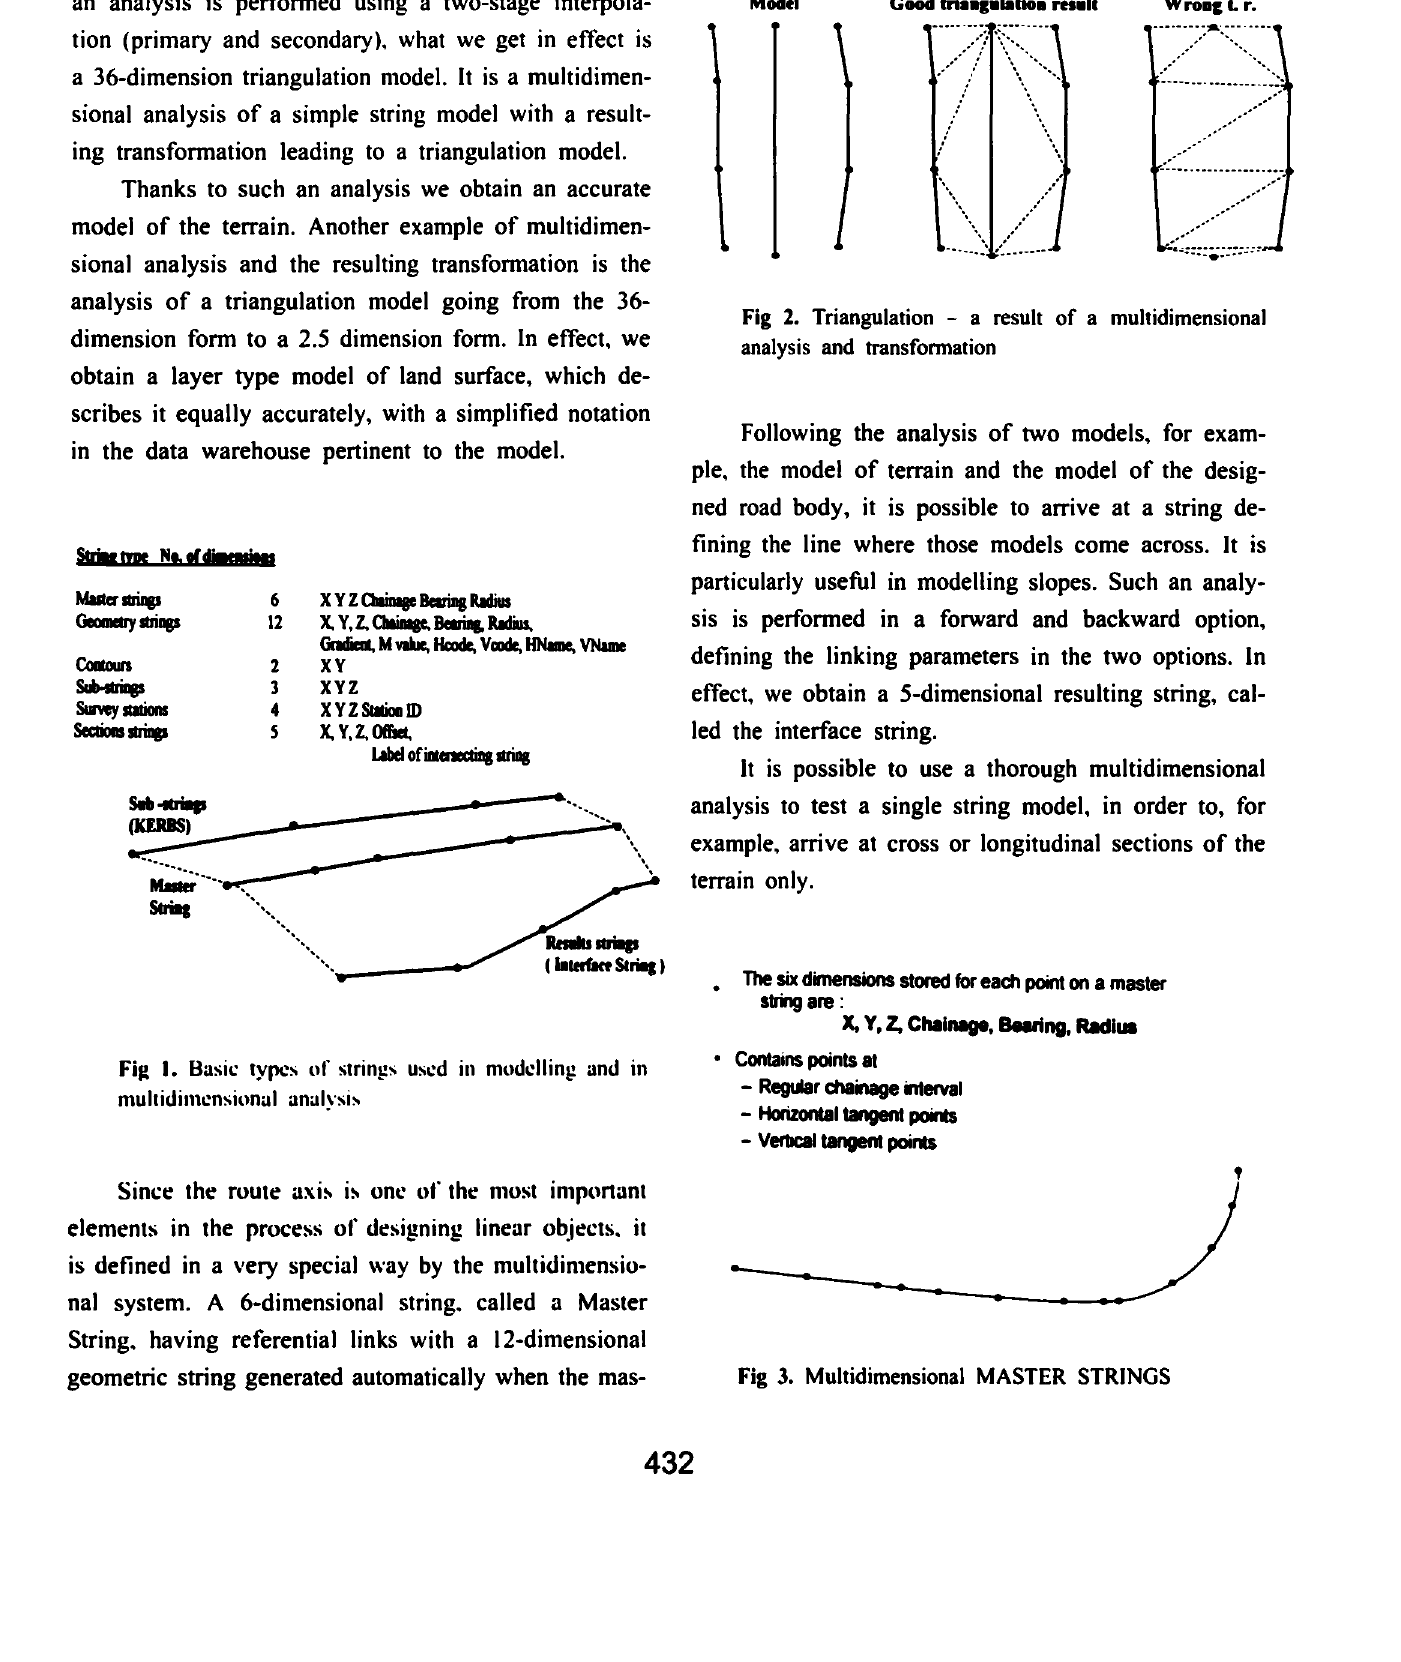
Fig 2. Triangulation - a result of a multidimensional analysis and transformation